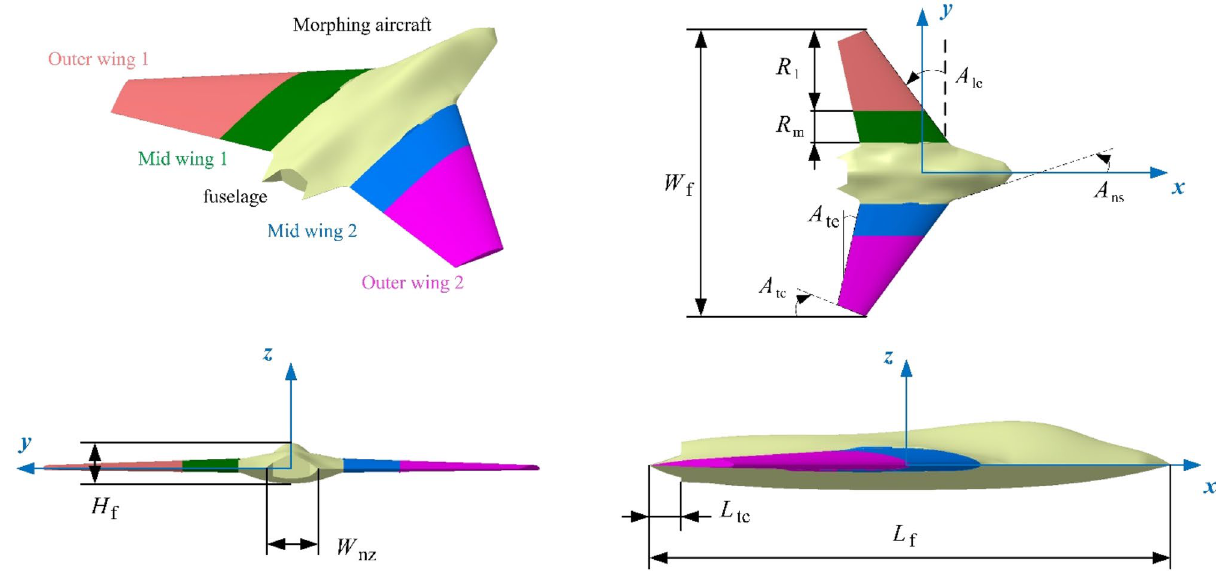
Figure 3. Aircraft model and main parameter distribution.